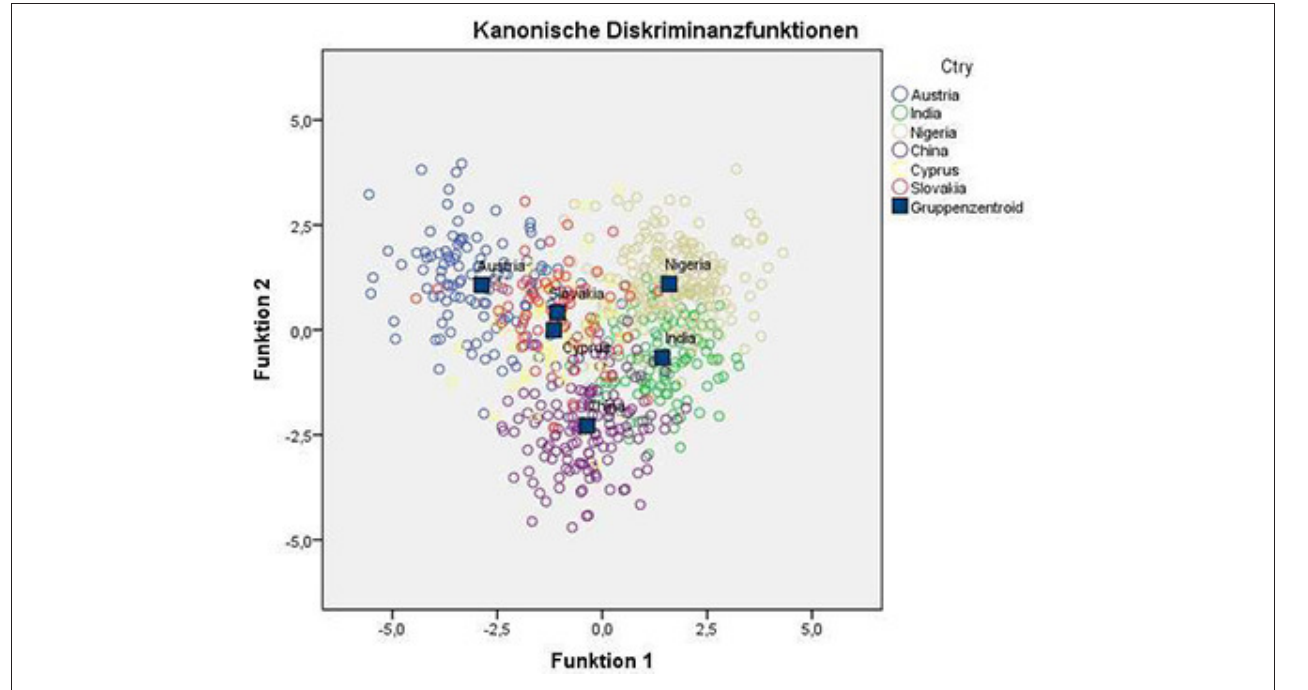
FIGURE 1 | Scatterplot of discriminant functions 1 and 2: group